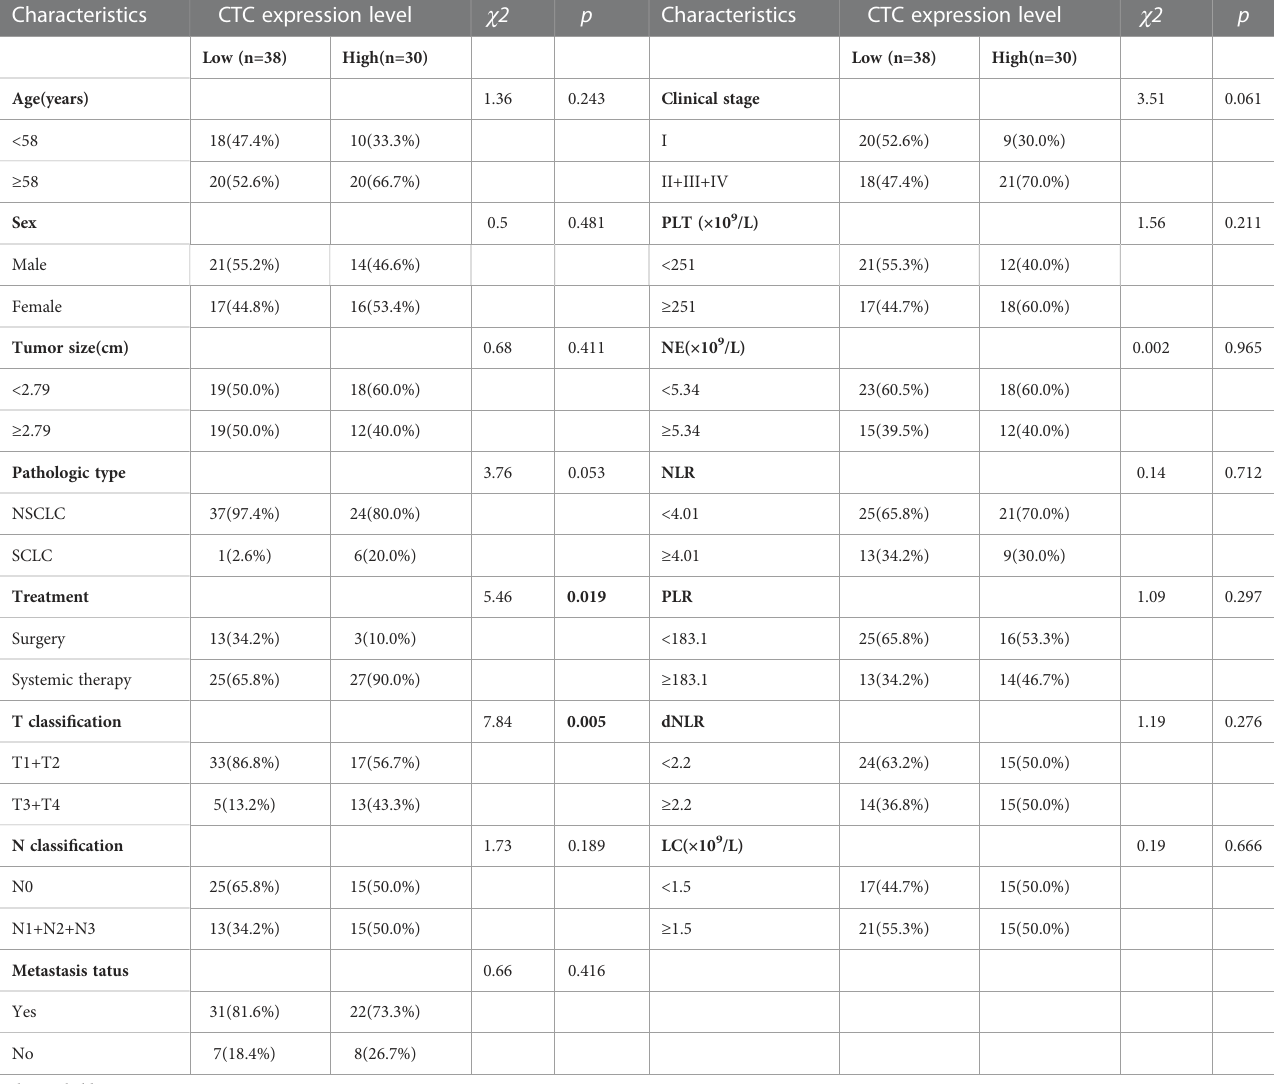
TABLE 2 Correlation between the FR + -CTC count and clinical characteristics.